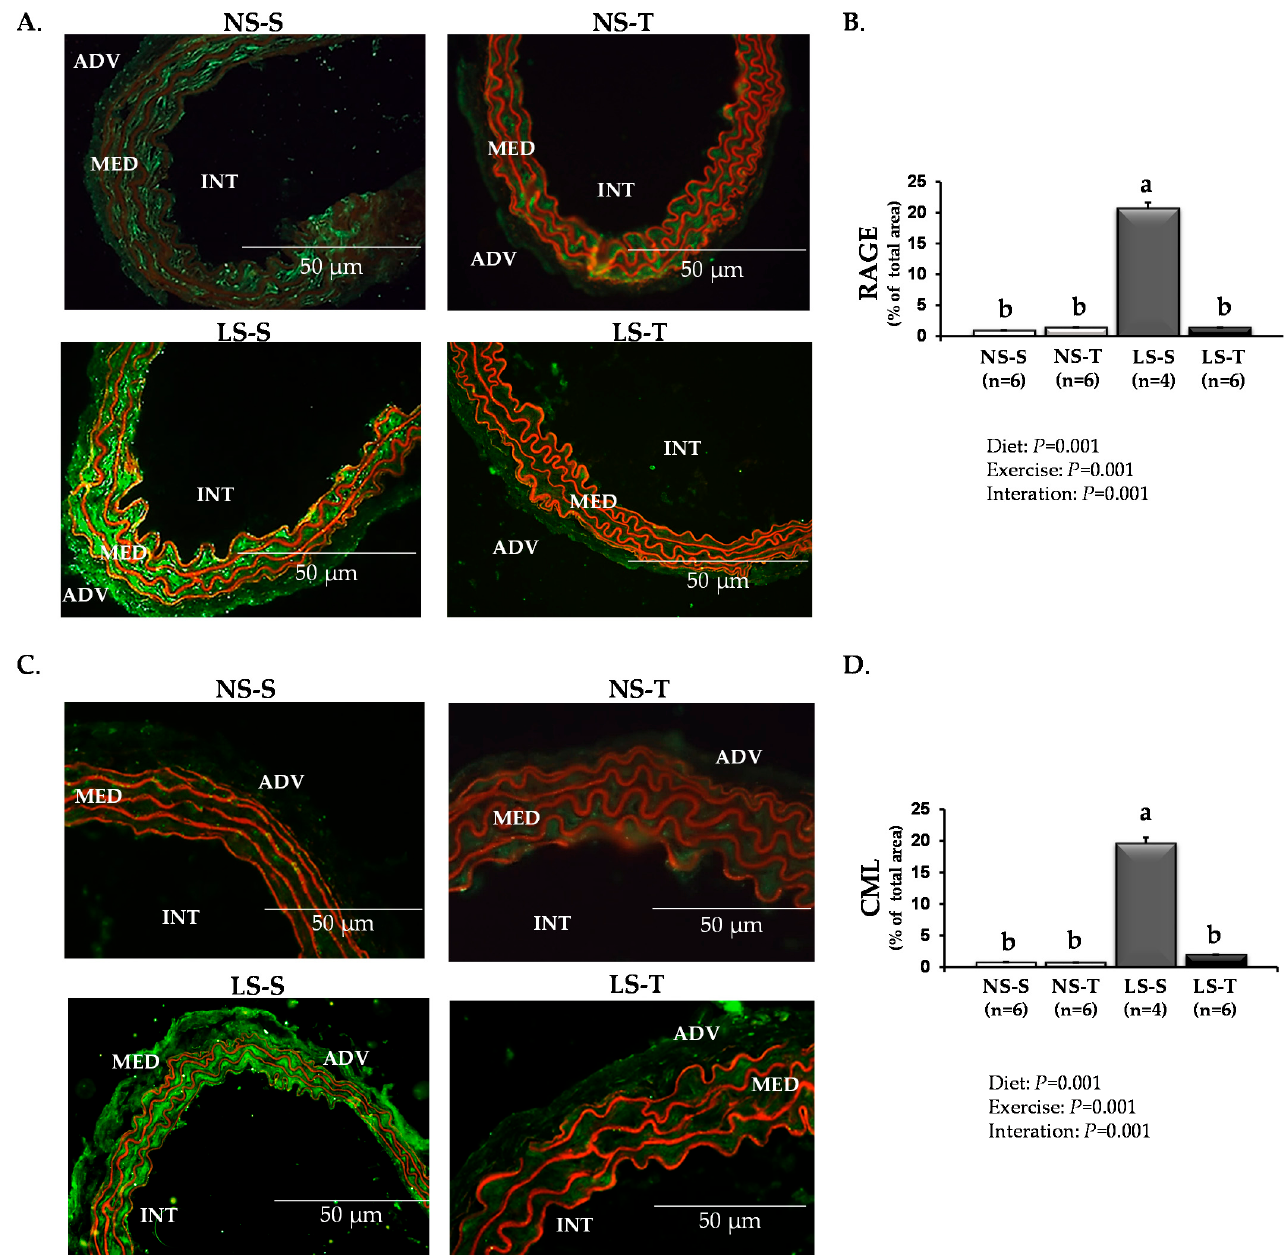
Figure 3. Vascular receptor for advanced glycation end products (RAGE) and carboxymethyllysine (CML) in LDLR KO mice fed either a normal-sodium (NS) or a low-sodium (LS) diet, trained (T) or sedentary (S), after 90 days. ( A ) Representative micrographs of immunofluorescence-stained RAGE in the brachiocephalic trunk. The green immunostaining indicates the RAGE expression. ( B ) Histo- morphometric analysis of immunofluorescence-stained RAGE. ( C ) Representative micrographs of immunofluorescence-stained CML in the brachiocephalic trunk. The green immunostaining indicates the CML expression. ( D ) Histomorphometric analysis of immunofluorescence-stained CML. ADV, adventitia; MED, media; INT, intima (400×). Red staining indicates counterstaining by 0.006% Evans blue dye. Two-way ANOVA test with two fixed factors (diet and exercise) and Tukey’s post-test were applied for comparisons among data. Results are expressed as mean ± standard deviation. Distinct letters represent differences among groups ( p < 0.05). n = number of mice.